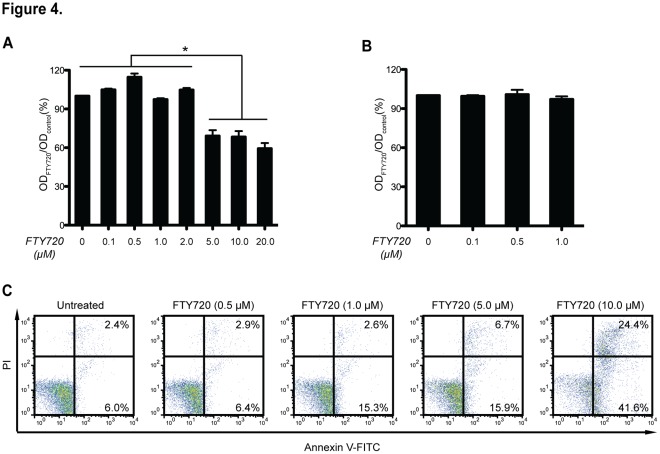
Cell viability determination.(A) MTT assays on the bone marrow cells. Mouse bone marrow cells were isolated and exposed to FTY720 with different concentrations for 48 h. Cytotoxicity was indicated by the ratio of ODFTY720 to ODcontrol. Data are shown as mean ± SEM. *P<0.05, n = 3. (B) MTT assays on BMDCs. Day 6 BMDCs were treated with FTY720 at concentrations of 0, 0.1, 0.5 and 1.0 µM for 48 h. Data are shown as mean ± SEM. *P<0.05, n = 3. (C) Apoptosis assays on BMDCs. The cell death rates of BMDCs was determined by Annexin V-FITC and PI staining flow cytometry. Cells were treated with FTY720 for 48 h at concentrations ranged from 0.5 to 10 µM.